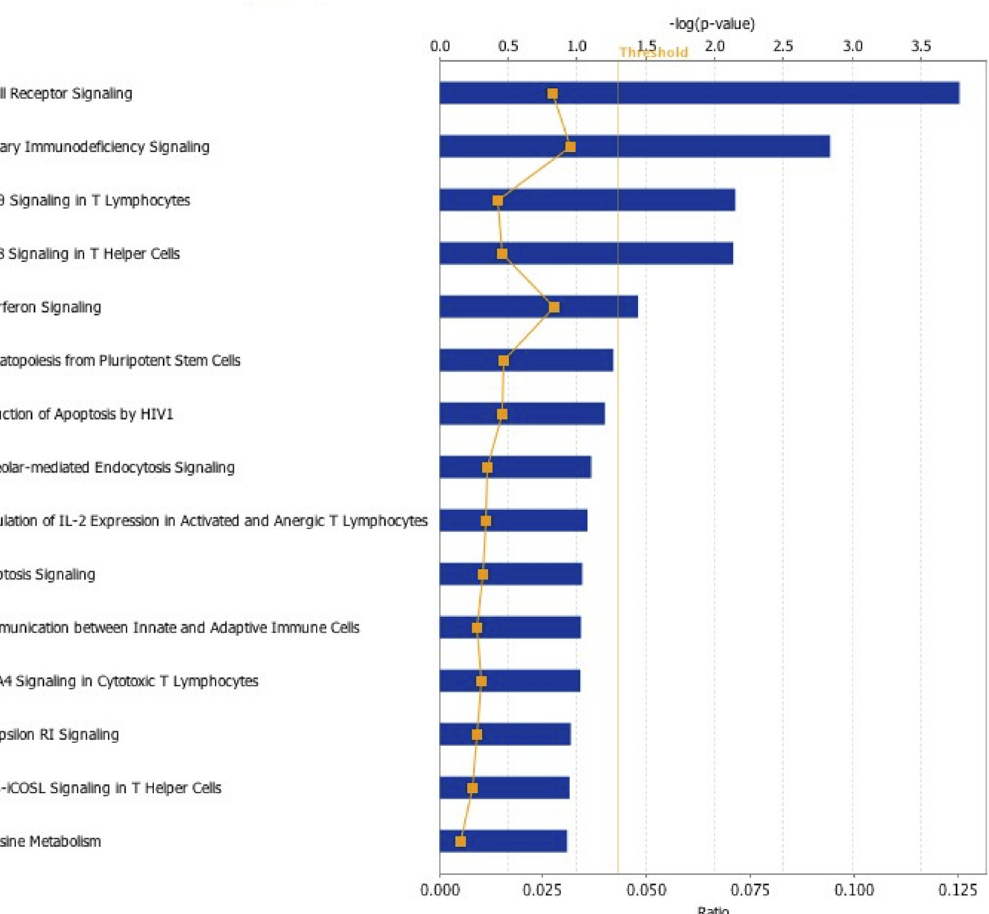
Fig 1. Ingenuity pathway analysis showing the most highly scoring canonical pathways (according to P value) associated with the response of thymocytes to CAV infection. Five pathways had a P value < 0.05. The orange line represents the ratio of the number of differentially expressed thymus genes in a particular pathway whose expression is correlated with cellular response towards CAV divided by the total number of genes that make up that pathway. Blue bars represent the P value for each pathway and are expressed as -1 times the log of the P value. The threshold line corresponds to a P value of